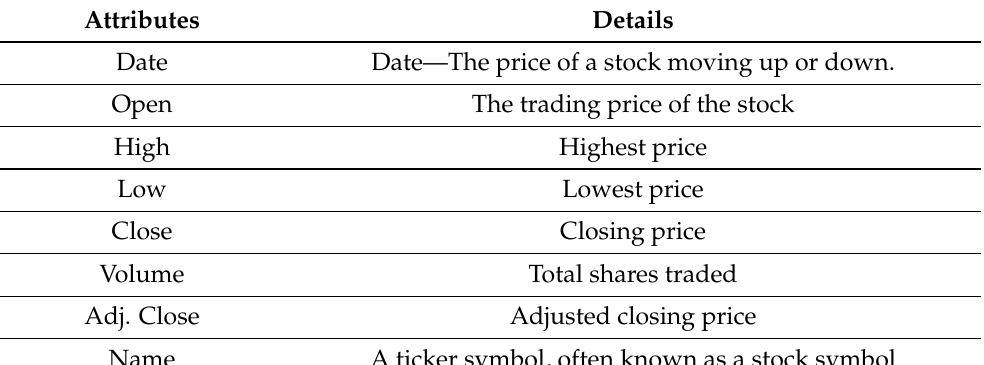
Table 5. Attributes of global stock market